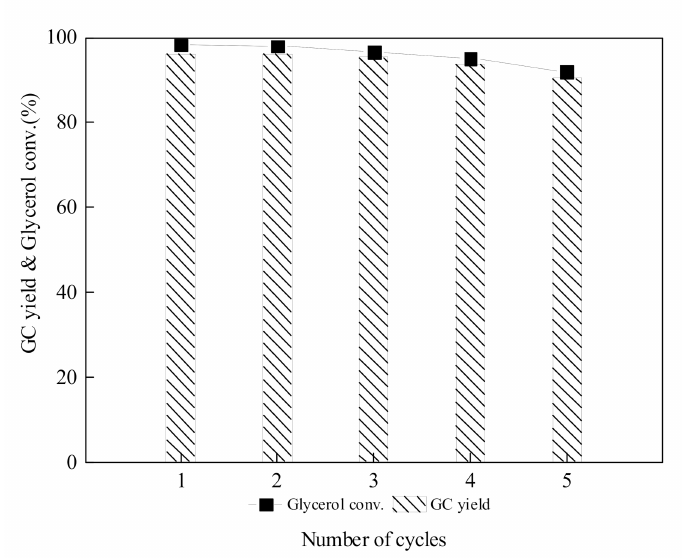
Figure 8. Reusability of